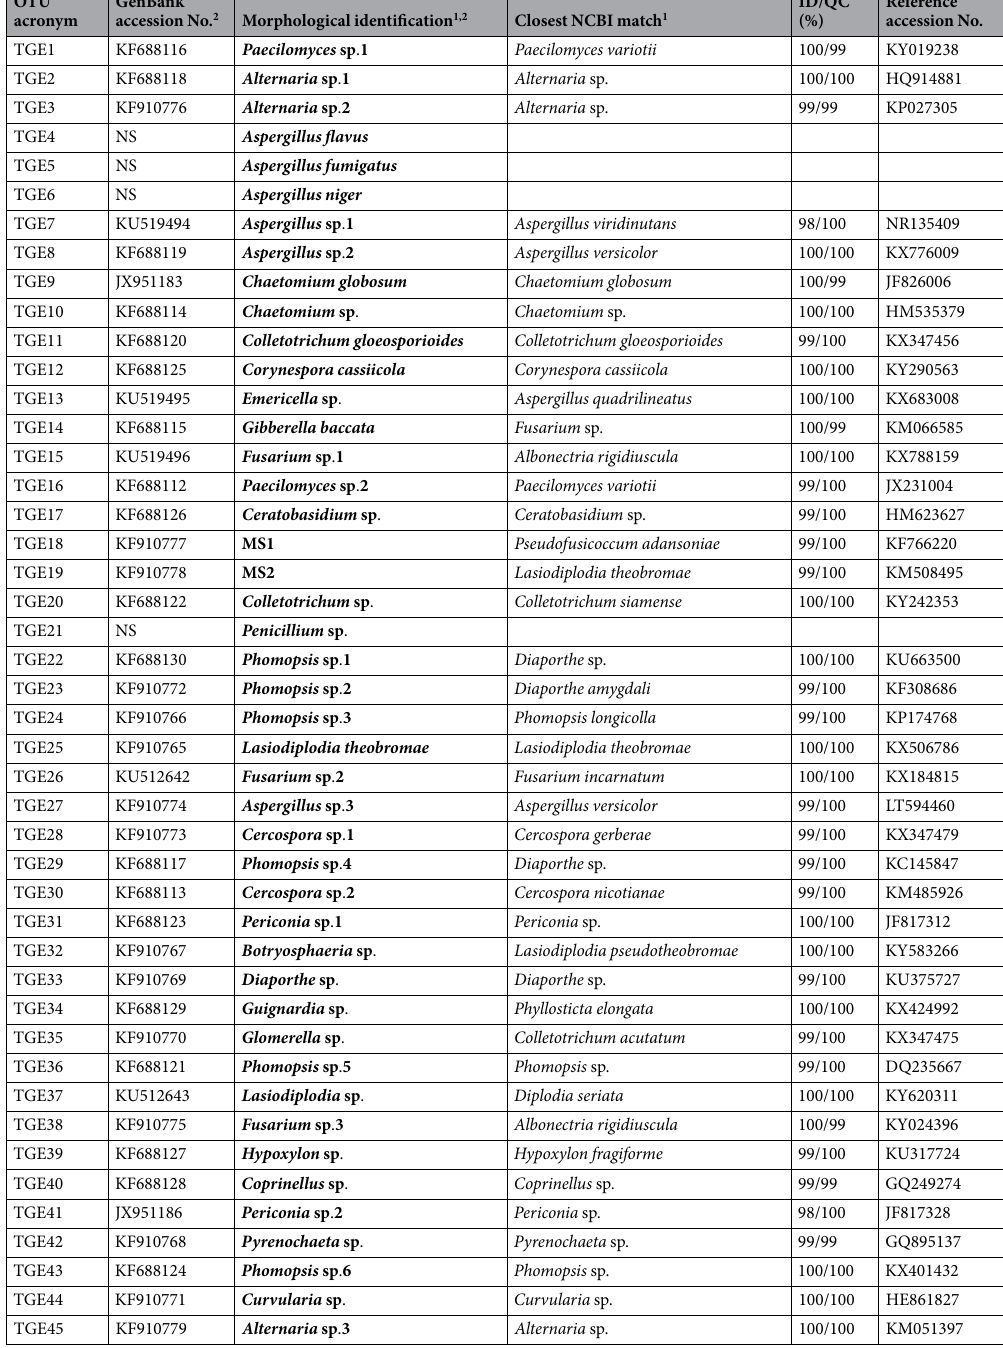
Table 1. Morphological and molecular (based on nrITS1 sequencing) identification of different OTUs, their closest match from NCBI database with their accession number, similarity (%ID) and query coverage